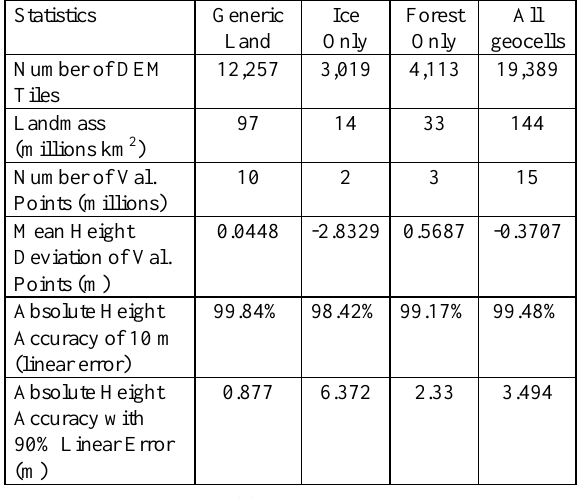
Table 2. Summary of final Absolute Height Accuracy The comparison of the different categories in the table shows that geocells dominated by ice or forest, which are affected by volume decorrelation, have reduced absolute height accuracy.